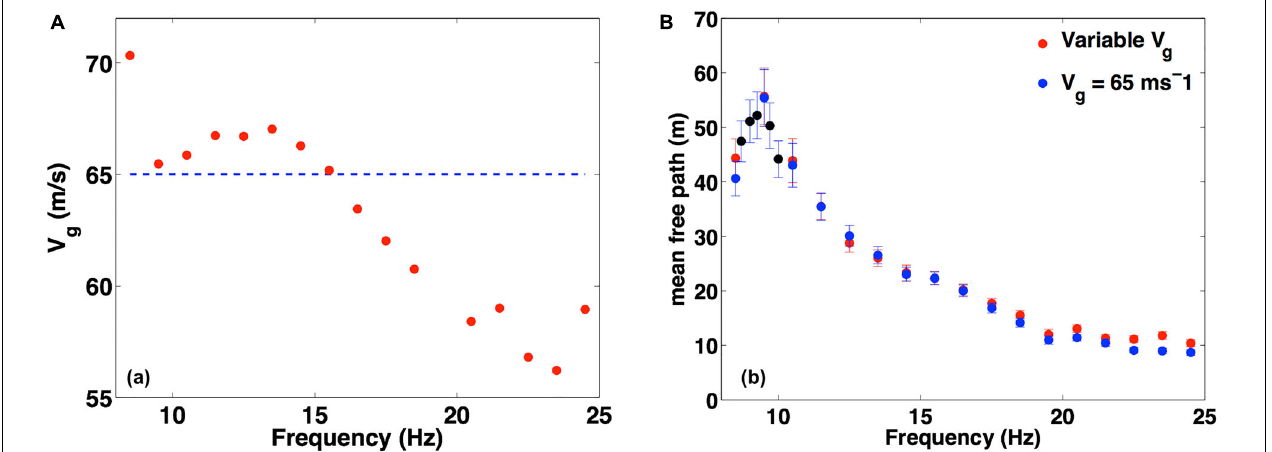
FIGURE 5 | (A) Group velocity V g as inferred from the maxima of the intensity ratio (red dots) compared to the fixed, average value of V g = 65 m/s (blue dashed line). (B) l s as a function of frequency for the two cases of the panel (A) . A hump at low frequency emerges from the scattering mean free path computation.